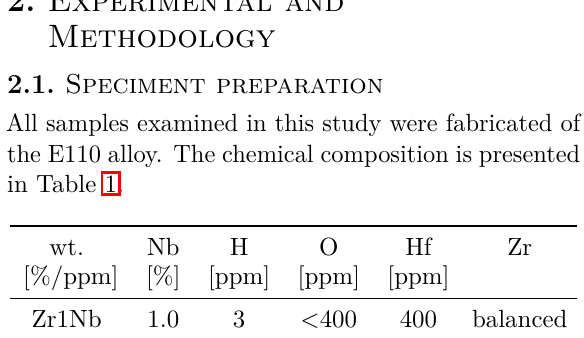
Table 1. The chemical composition of studied